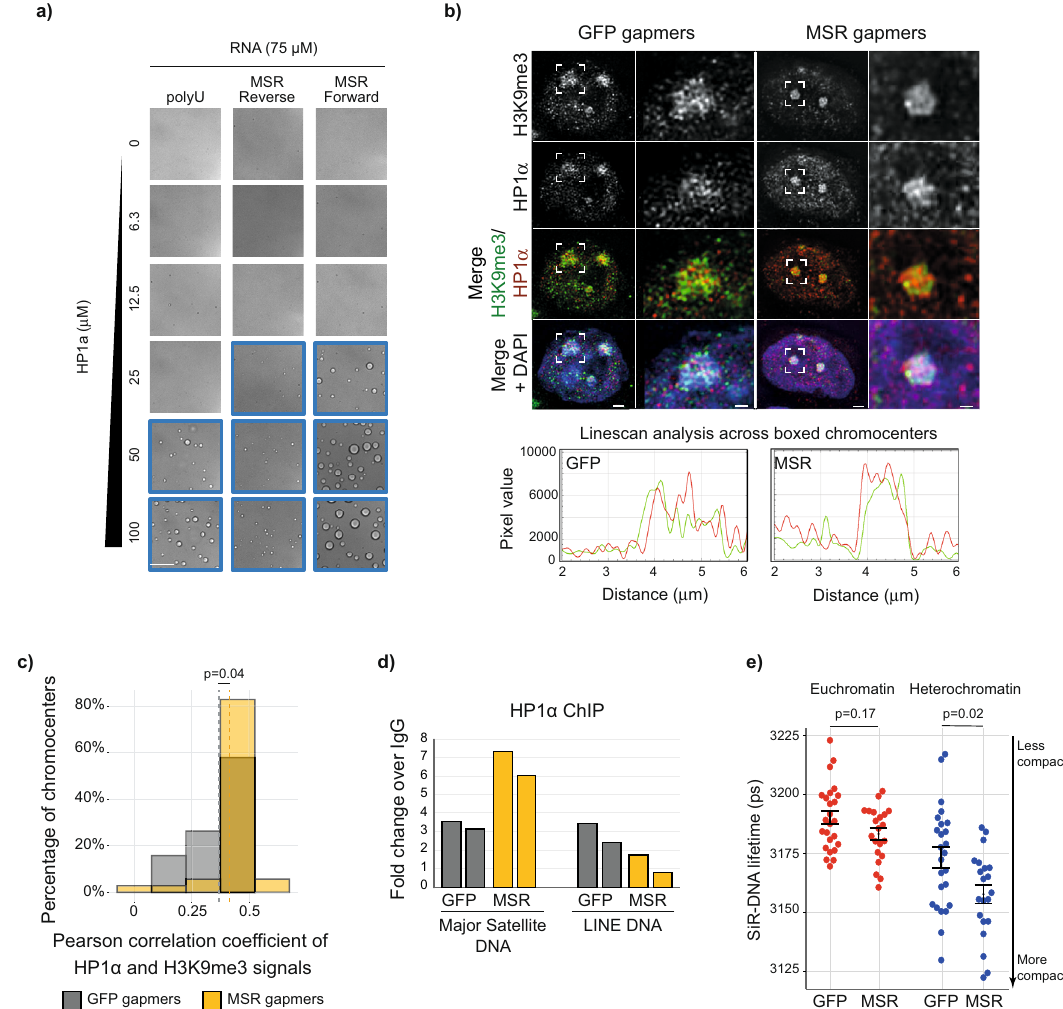
Fig. 3 Satellite RNA promotes phase-separation of the heterochromatin protein, HP1 ɑ . a In vitro transcribed MSR RNAs, or synthetic polyU RNA, were added to increasing concentrations of recombinant HP1 ɑ protein. Images framed in blue show the conditions that allowed for the formation of HP1 ɑ droplets. All images show the same magni fi cation; scale bar, 100 μ m. b Representative images of 3D reconstructions acquired with SIM, showing details of DAPI, H3K9me3 and HP1 ɑ organisation at chromocenters in ESCs that were transfected with GFP or MSR gapmers (scale bars, 2 μ m). White boxes indicate zoomed-in areas shown to the right (scale bars, 0.5 μ m). Linescan analyses of the boxed chromocenters are shown below and reveal the overlap of heterochromatin marks at chromocenters (HP1 ɑ , red line; H3K9me3, green line). c Histogram showing the Pearson ’ s correlation coef fi cients of H3K9me3 and HP1 ɑ signal intensities on a pixel-by-pixel basis at chromocenters, as measured using confocal analysis of chromocenter mid-sections. Vertical dashed lines show the mean Person correlation coef fi cient for n = 1981 and n = 5523 chromocenters quanti fi ed in 19 (761 cells) and 34 (1045 cells) images acquired after N = 2 independent GFP and MSR gapmer transfection experiments, respectively. Samples were compared with a two-sided Mann – Whitney test. d Histograms of ChIP results show the fold-change over IgG of HP1 ɑ bound at MSR DNA or LINE DNA upon transfection of ESCs with GFP or MSR gapmers. N = 2 biologically independent samples are shown. e Plot shows the fl uorescence lifetime of the far-red dye SiR-DNA in both euchromatin and heterochromatin regions of nuclei following the transfection of ESCs with GFP or MSR gapmers. Each point represents the mean lifetime intensity per image from three independent experiments, each with >8 images per sample. Shorter fl uorescence lifetime means increased chromatin compaction. Samples were compared with a two-sided Mann – Whitney test; error bars in black show mean ± SEM. See also Supplementary Fig. 3 and Supplementary Movies 7a and heterochromatinisation and compaction of chromatin within these domains.